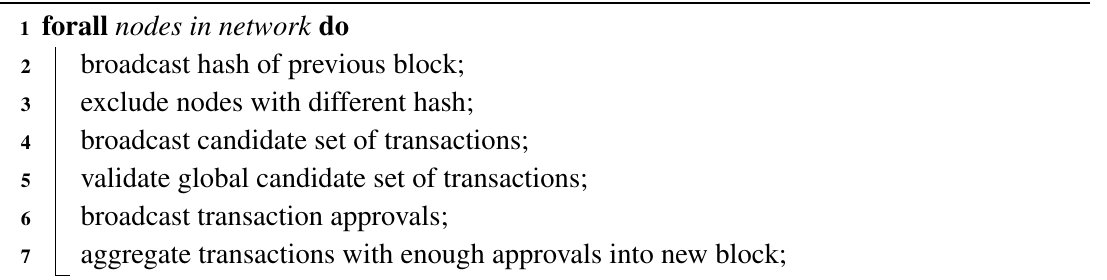
Algorithm 1: Generalized Consensus